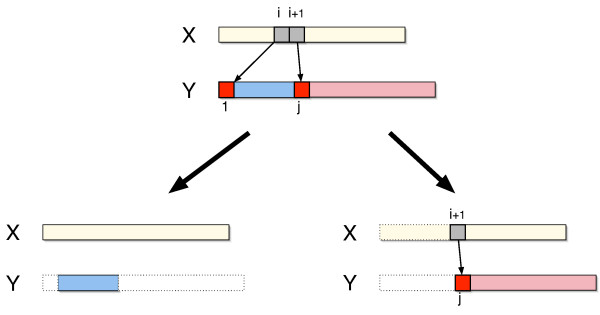
Recurrence: Case 2. y1 is generated from xi in a duplicate operation where y1 is not the last (rightmost) character in a copied substring (Case 2). In this case, xi+1 is also copied in the same duplicate operation (top). Thus, the duplication distance is the sum of d(x, y2, j-1), the duplication distance for y2, j-1 (bottom left), and di+1(x, yj, |y|), the minimum number of duplicate operations to generate yj, |y| given that xi+1 generates yj (bottom right).